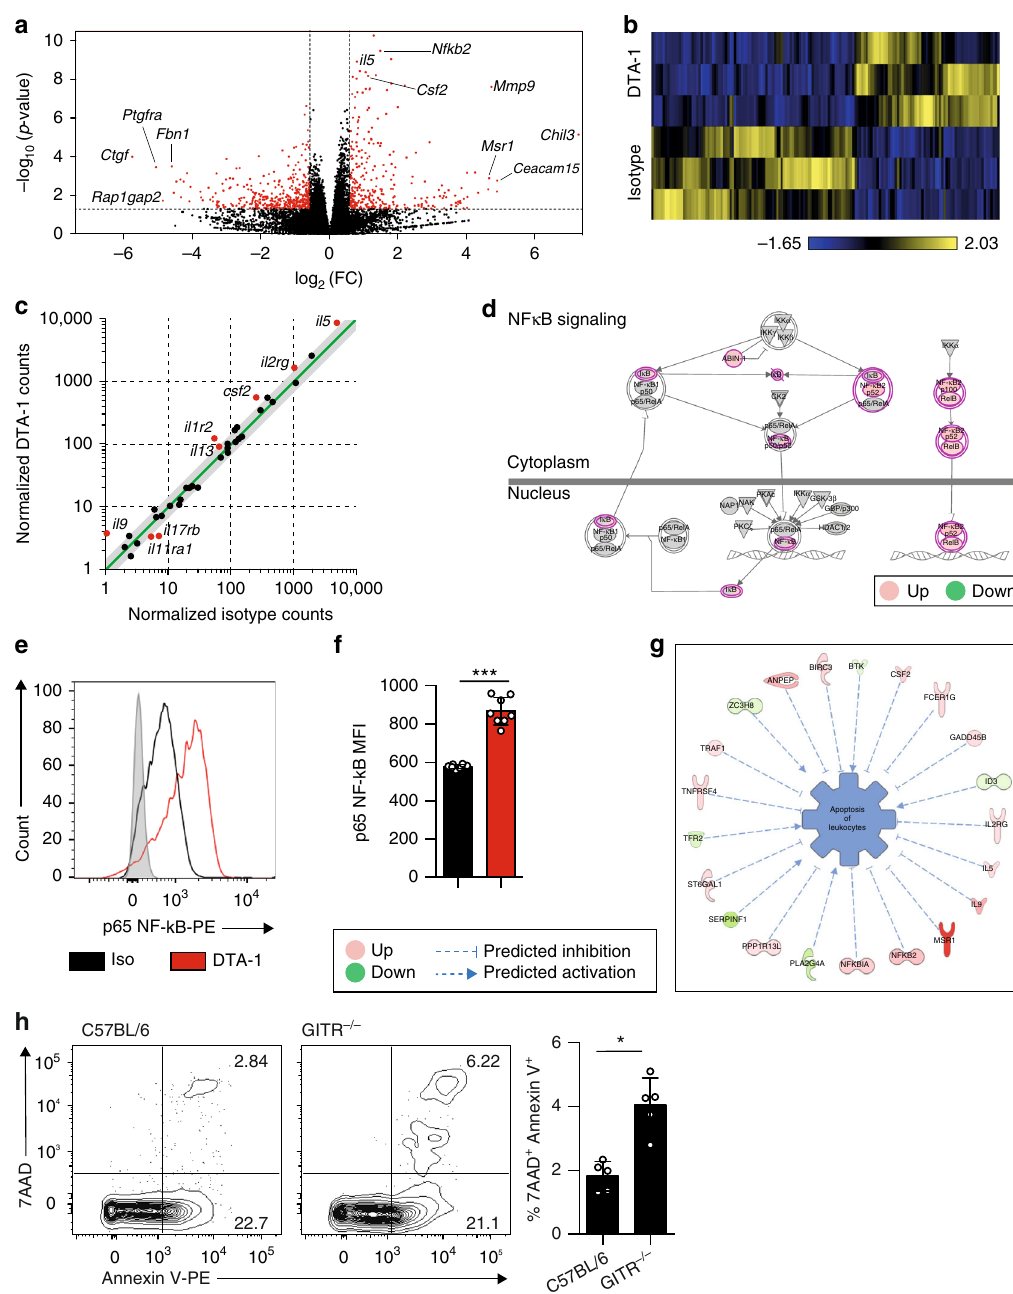
Fig. 7 GITR engagement induces NF- κ B pathway signaling in ILC2s. a Volcano plot comparison of whole transcriptome gene expression of sorted WT ILC2s from VAT treated with isotype control or DTA-1 (5 µ g/mL) for 24 h in vitro, n = 3. Differentially expressed genes (de fi ned as statistically signi fi cant adjusted p -value < 0.05) with changes of at least 1.5 fold-change (FC) are shown in red. Notable differentially expressed genes are labeled. b Heat plot of differentially expressed genes. c Selected genes plotted as the normalized counts in isotype control-treated compared to DTA-1-treated mice. Differentially expressed genes (de fi ned as in a) are shown in red. Gray area indicates region of 1.5 fold-change cutoff or lower change in expression. Shown are expression of cytokine and cytokine receptor genes. d Upregulated (red) and downregulated (green) genes in the NF- κ B pathway. e Representative histogram of the expression of NF- κ B p65 in isolated ILC2s from mice challenged with IL-33 and cultured in vitro for 24 h with DTA-1 (red) or isotype control (black). The level of isotype-matched stain control is shown as a gray- fi lled histogram. f Corresponding quanti fi cation presented as Mean Fluorescence Intensity of NF- κ B p65 with DTA-1 or isotype control. g Network analysis of upregulated (red) and downregulated (green) genes overall signi fi cantly predicted to inhibit the apoptosis of leukocytes. h Representative fl ow cytometry plots of VAT Lin - CD45 + IL-7R + ST2 + Annexin V + 7-AAD + ILC2s from C57/BL6 or GITR -/- mice ( n = 5) and corresponding quantitation presented as the percentage of ILC2s. Error bars are the mean ± SEM. Student ’ s t -test, * p < 0.05, *** p <